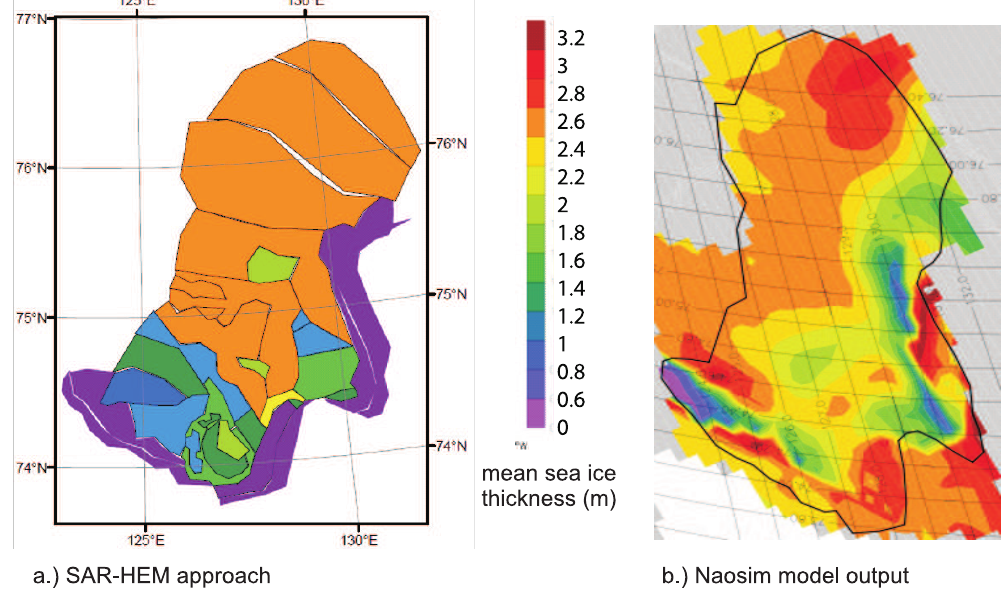
Fig. 8. Areas of sea ice that originated after polynya openings along the fast ice edge during the 116-day-long survey period. The color code refers to mean ice thickness. (a) Results from SAR tracking and HEM surveying. (b) Results from NAOSIM model.